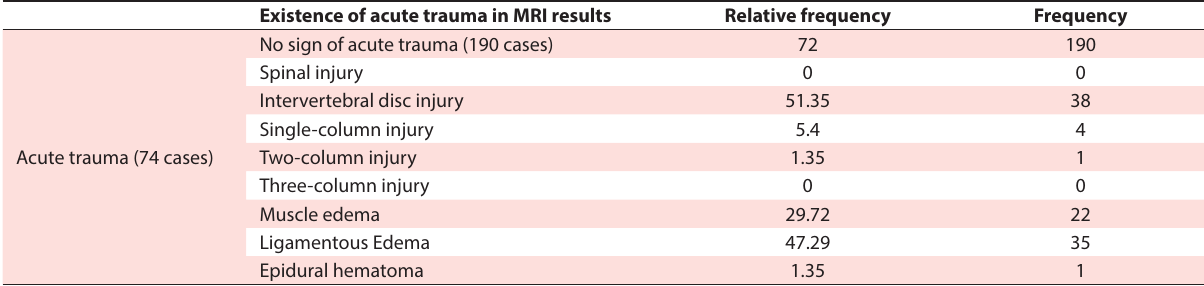
Table 3. Frequency and relative frequency of acute trauma in neck MRI results and type of trauma in patients Existence of acute trauma in MRI results